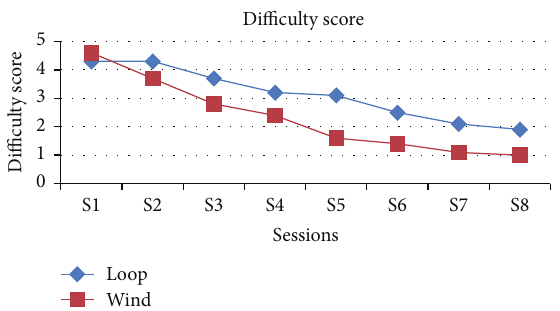
Figure 6: Graphical representation of both groups in view of difficulty in making knot in the end of each session.